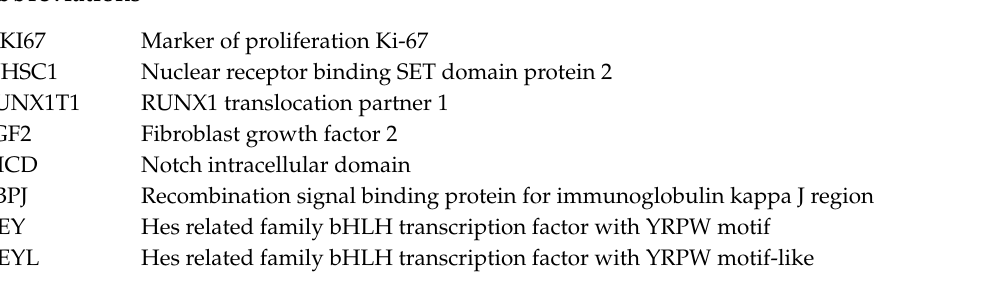
Table S1: List of identified genes in proliferative groups (E1 and E2) and differentiative groups (E3 and E4) based on the criterion of FPKM > 2. Table S2: List of identified miRNAs in proliferative groups (S1 and S2) and differentiative groups (S3 and S4). Table S3: DEGs in proliferation phase. Table S4: Significantly-enriched GO terms of upregulated DEGs. Table S5: Significantly-enriched GO terms of downregulated DEGs. Table S6: Significantly-enriched KEGG pathways of upregulated DEGs. Table S7: Significantly-enriched KEGG pathways of downregulated DEGs. Table S8: Significantly-enriched GO terms of predicted upregulated target DEGs of downregulated DEMs. Table S9: Significantly-enriched KEGG pathways of predicted upregulated target DEGs of downregulated DEMs. Table S10: Significantly-enriched GO terms of predicted downregulated target DEGs of upregulated DEMs. Table S11: Significantly-enriched KEGG pathways of predicted downregulated target DEGs of upregulated DEMs. Table S12: Primer sequence of DEGs in P-N1ICD versus P-Control group. Table S13: Primer sequence of DEGs in D-N1ICD versus D-Control group. Table S14: Primer sequence of